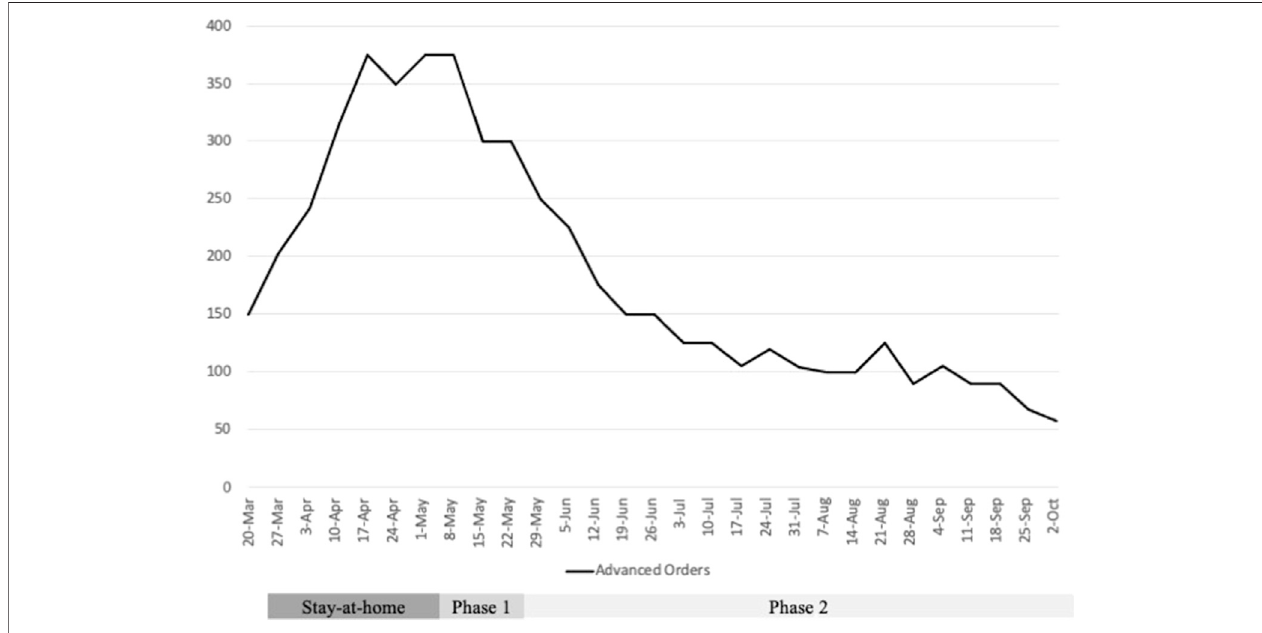
FIGURE 1 | Advanced orders at the corner farmers